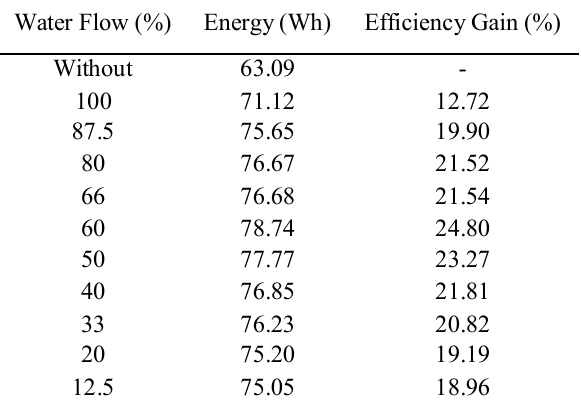
TABLE V E FFICIENCY GAIN OF THE PV PANEL WITH THE COOLING SYSTEM